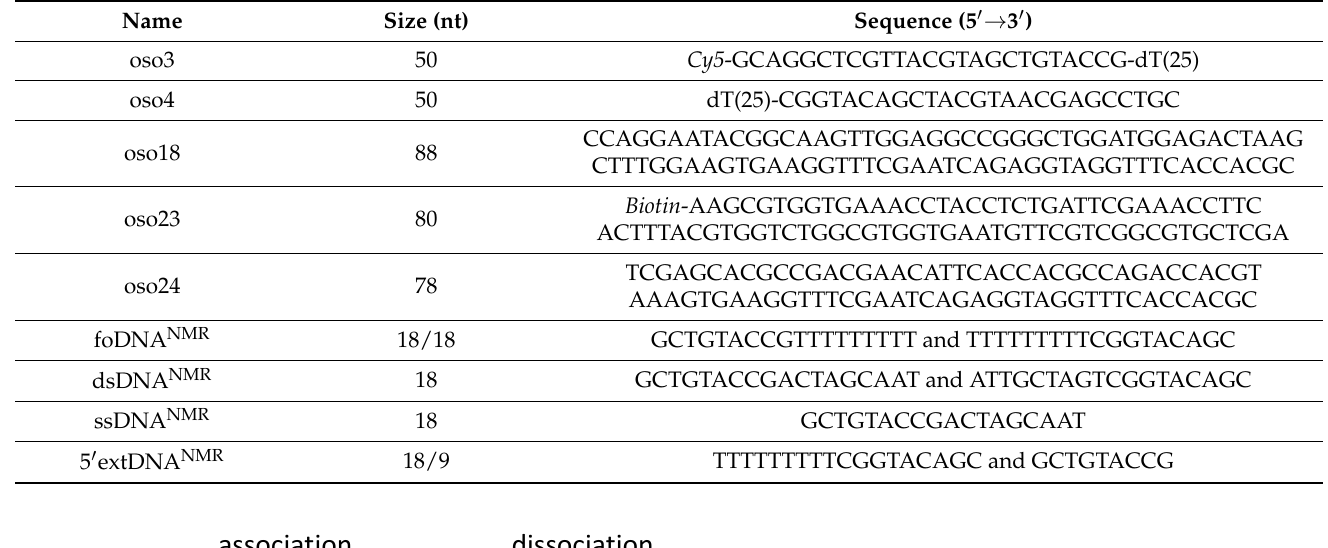
Table 1. Sequences of the oligonucleotides used in BLI and NMR analyses.